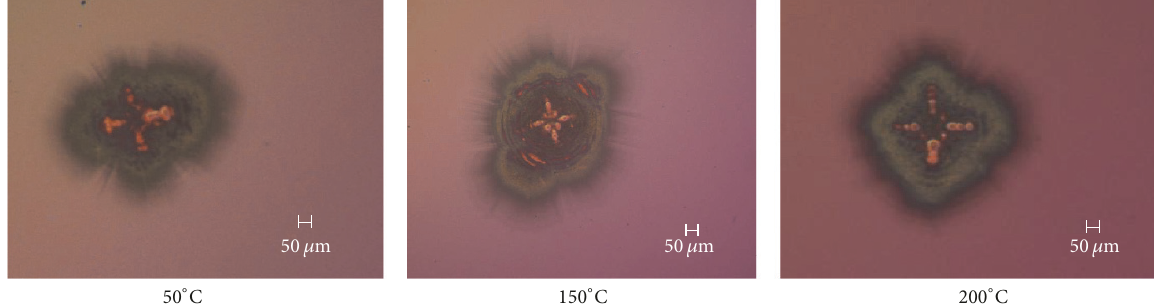
Figure 5: Damage morphologies of LaTiO 3 film prepared at different deposition temperature.